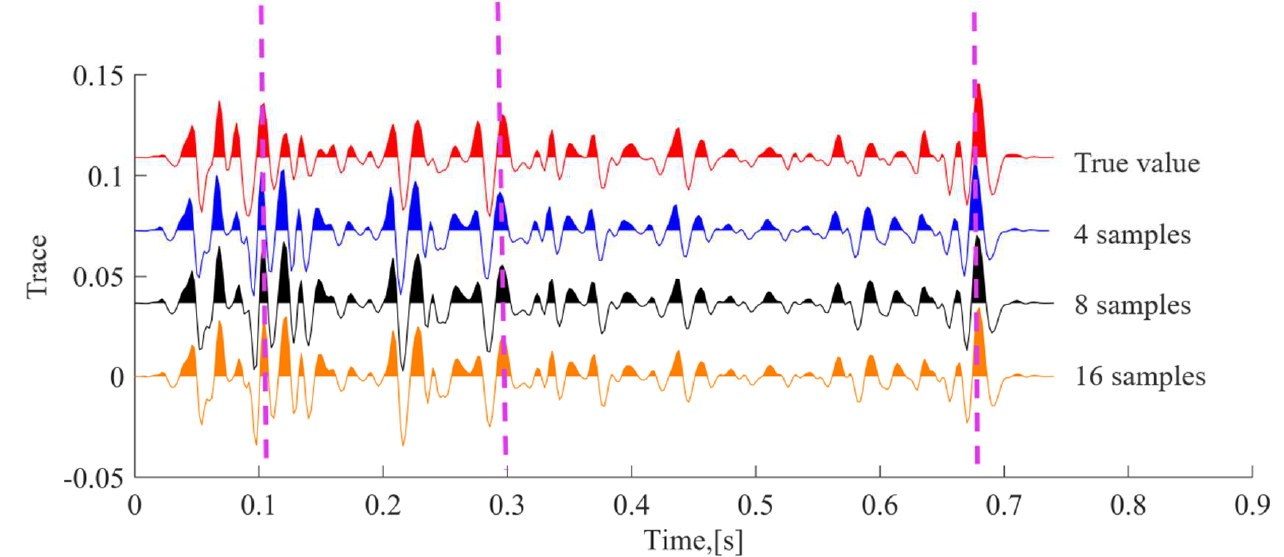
Figure 7. Comparison of synthetic seismic data by using upscaled velocity from three different sizes of sample window using the Backus averaging method.